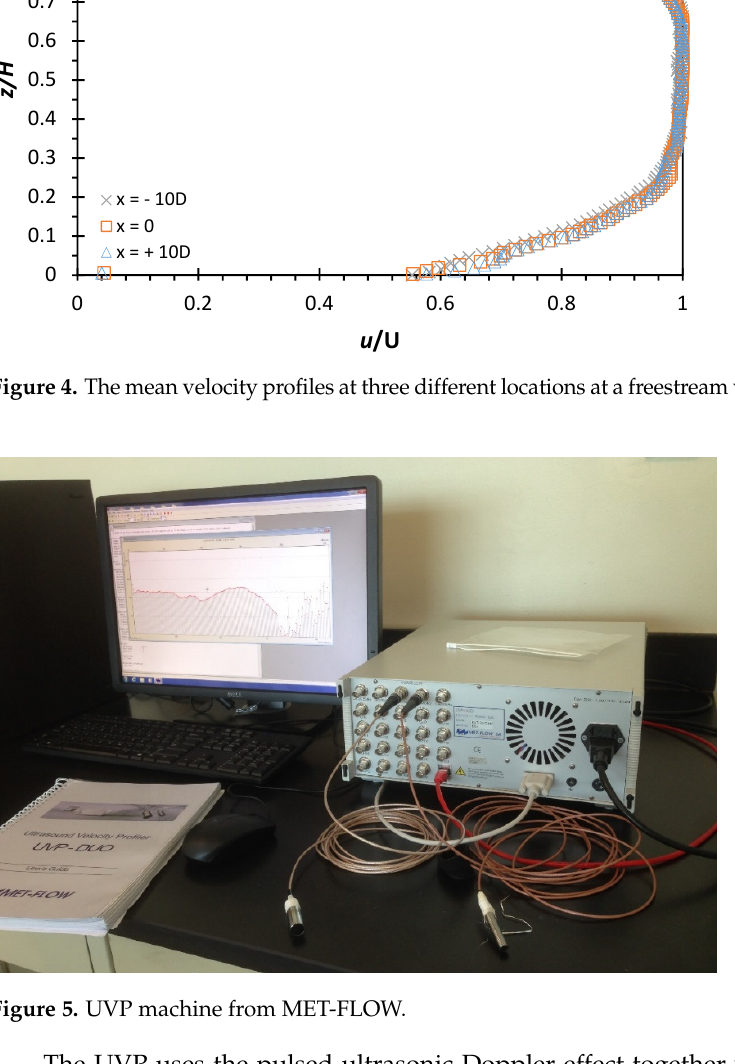
Figure 5. UVP machine from MET-FLOW.